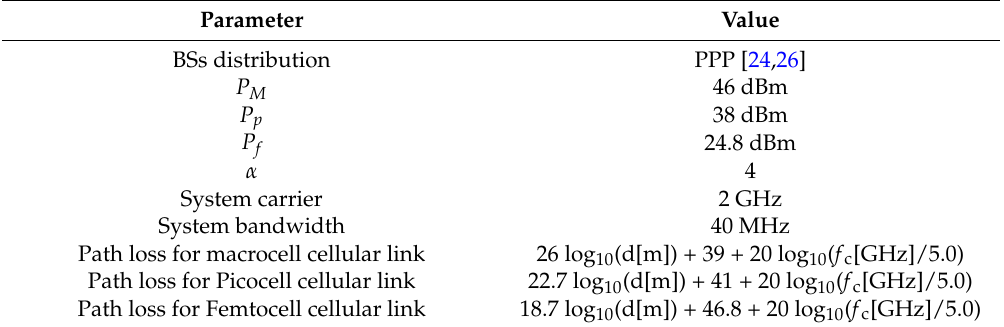
Table 1. Simulation